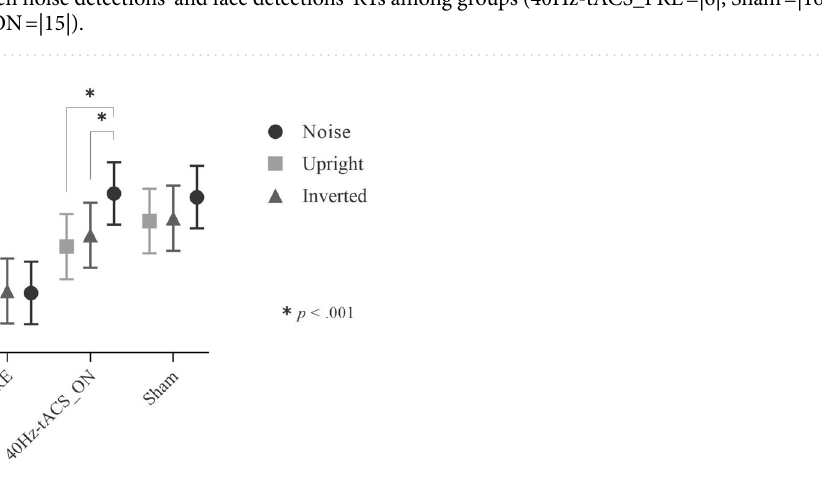
Figure 8. Group*Stimuli interaction for the Noise Pareidolia test. Post-hoc contrasts based on Stimuli. Participants in the 40Hz-tACS_ON group exhibited longer RTs for noise stimuli than for the upright and inverted ones. This suggests that online stimulation reduced participants’ speed in recognizing noise